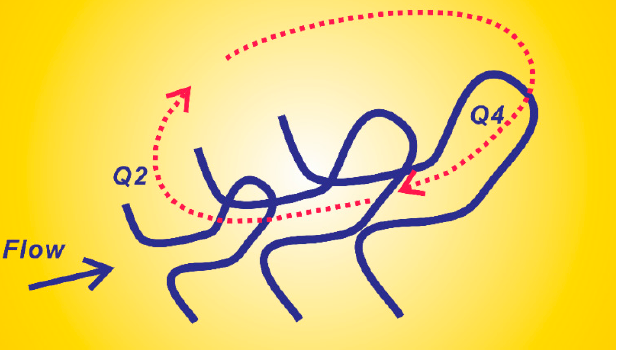
Figure 8. The formation of a large eddy due to the solenoidal effects of the hairpin vortex packets (reproduced from [24]).